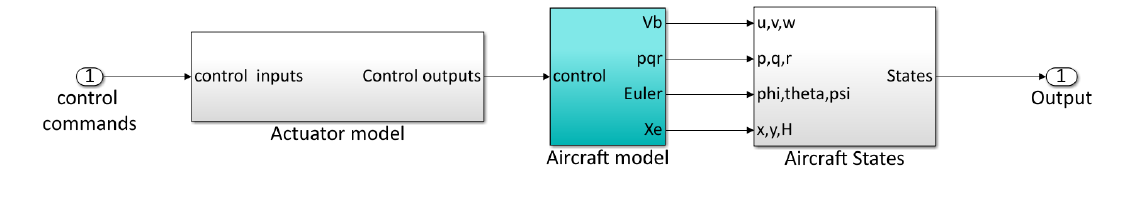
Figure 5. Aircraft model in Simulink.